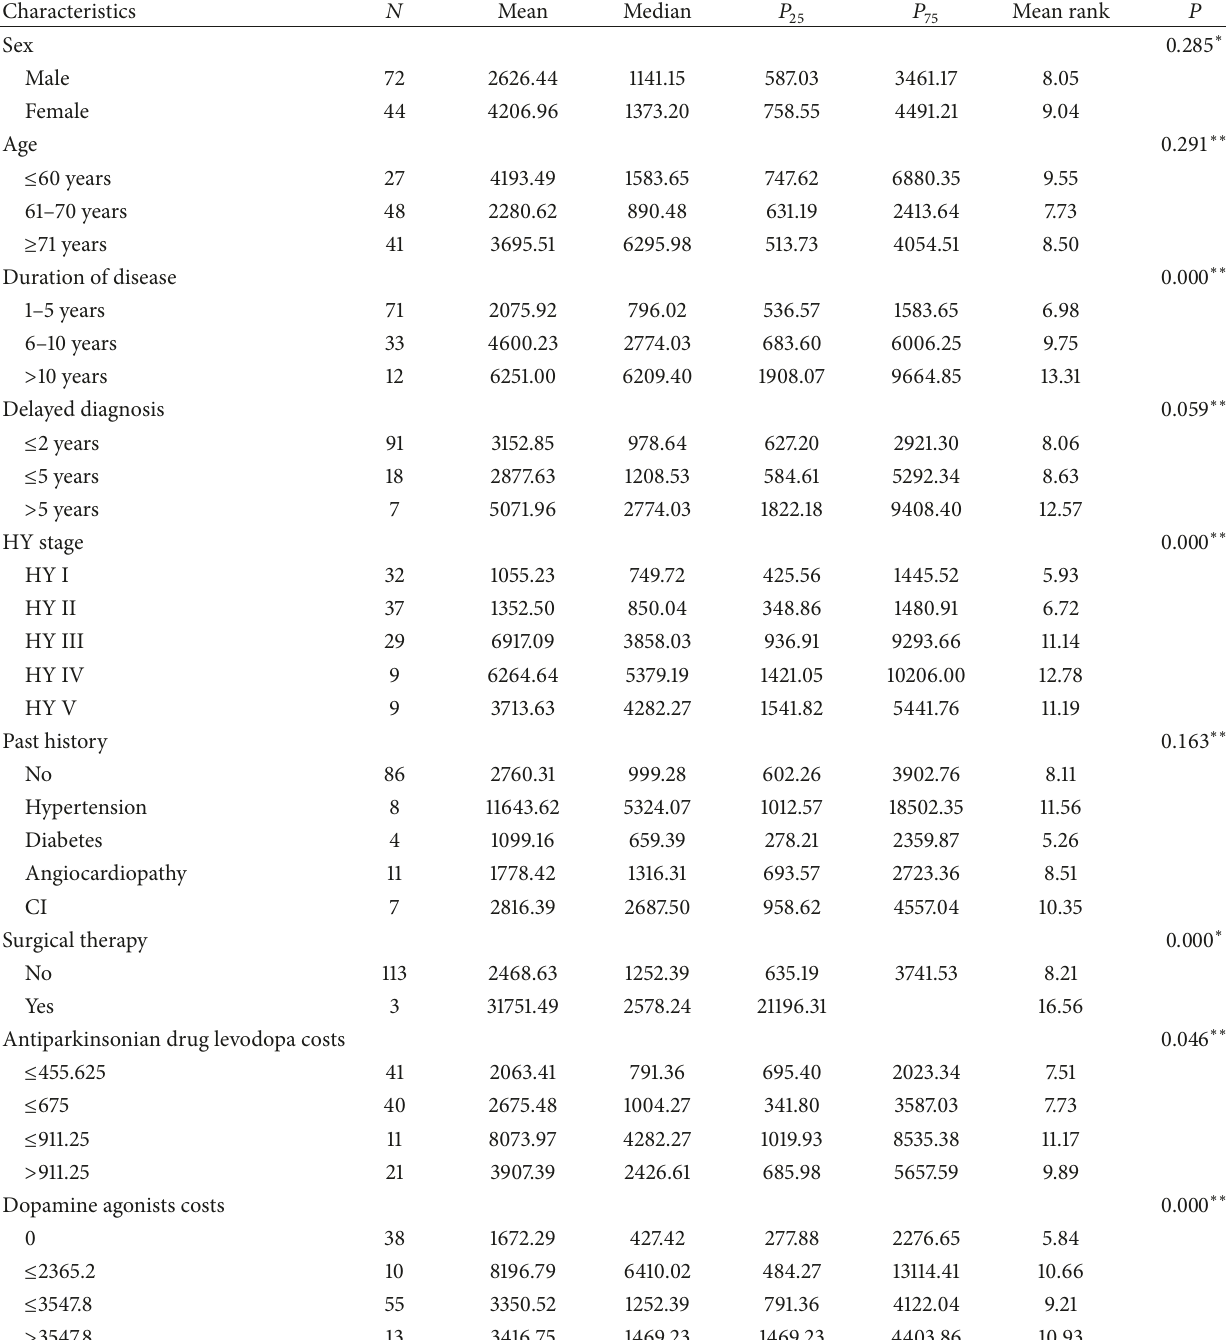
Table 3: Univariate analyses of contributions of various factors to the cost of PD ($, 2016 values).